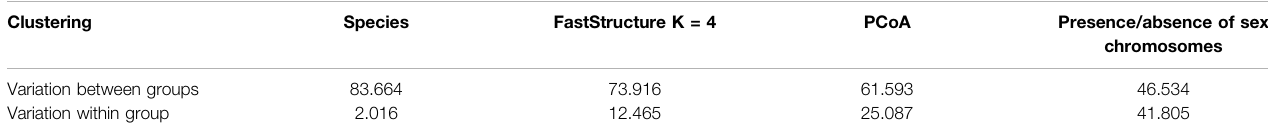
Variation between